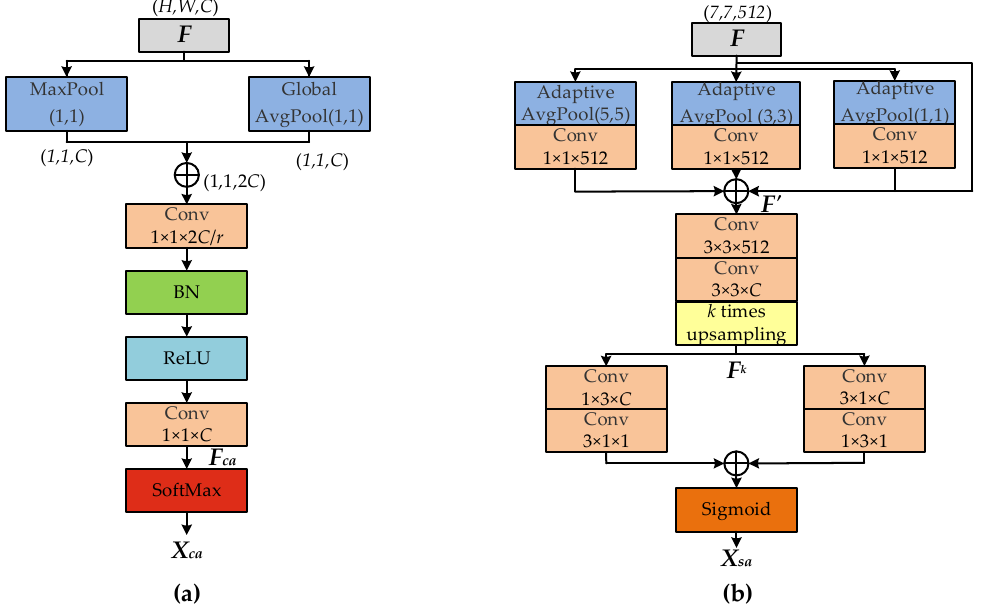
Figure 4. Improved attention modules: ( a ) Improved CAM; ( b ) Improved SAM.